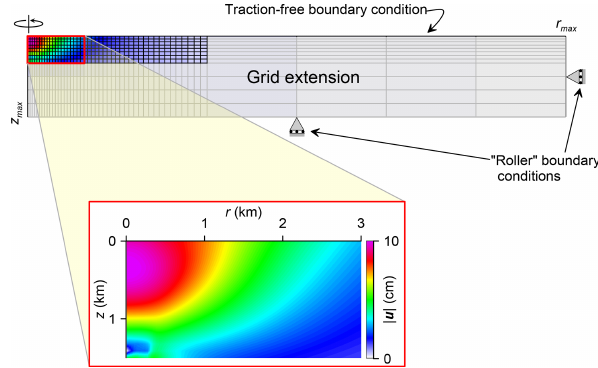
Figure 6. The domain and the boundary conditions for the geome- chanical simulation by method B. The mesh used for the fluid flow modelling is shown in black. The distribution of total displacement is shown at t = 20